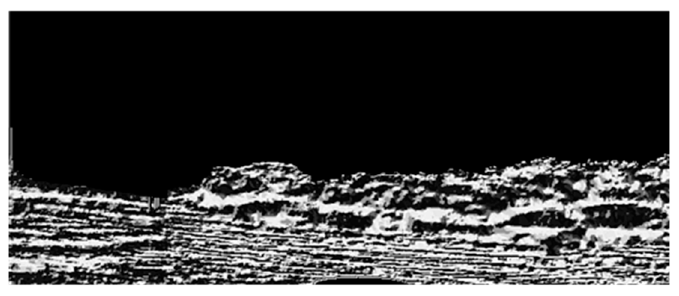
Figure 5. The result of LBP calculation based on our image preprocessing in Section 2.1.